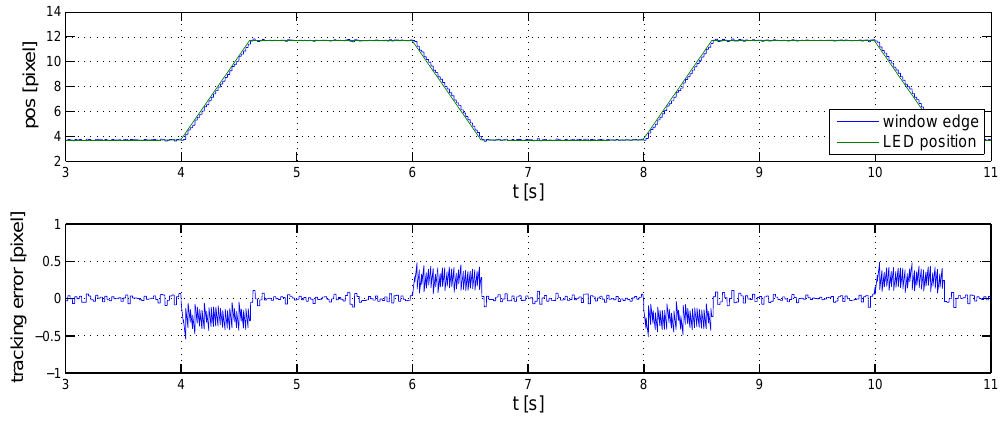
Figure 8. Initial controller, linear